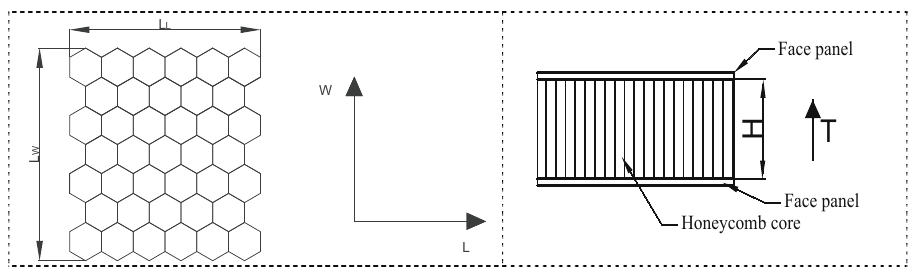
Figure 1: Structure and anisotropy direction of honeycomb.